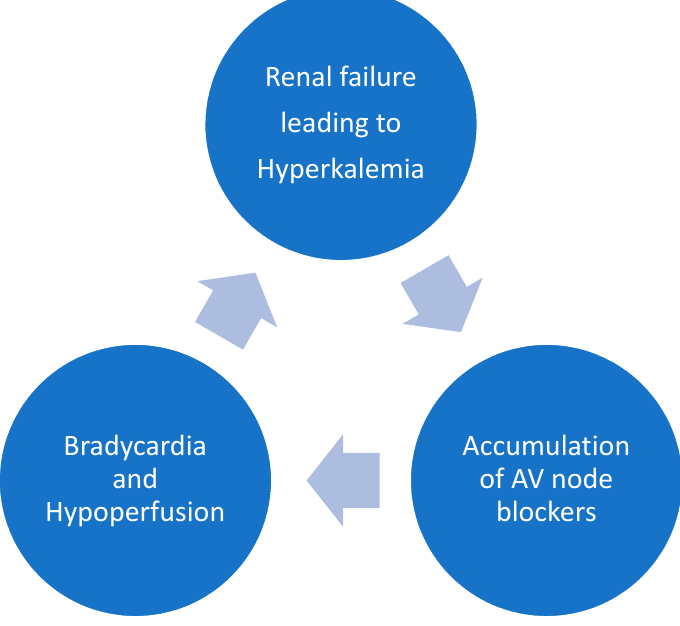
Figure 1. BRASH pathophysiology.